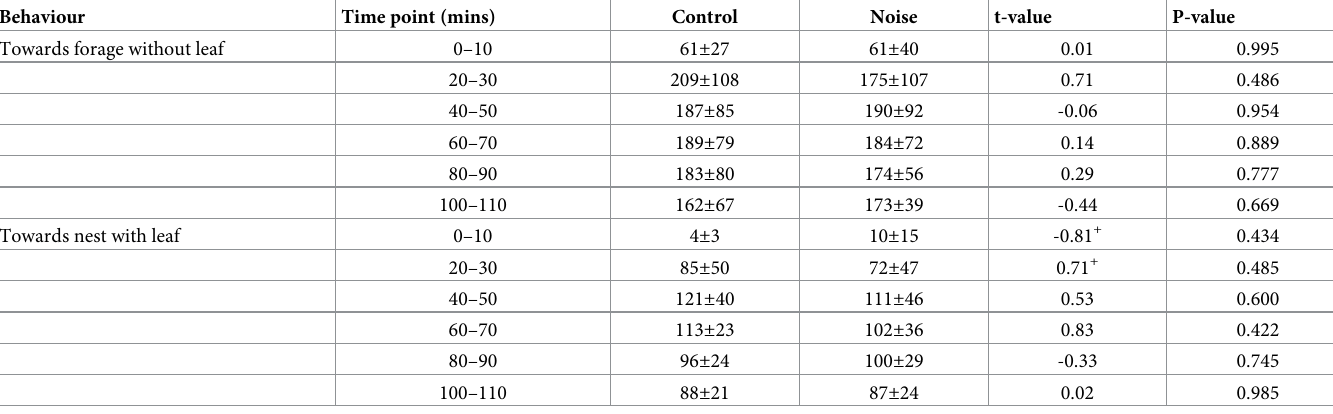
Test statistics are given for the comparisons between control and noise treatments. + indicates square root